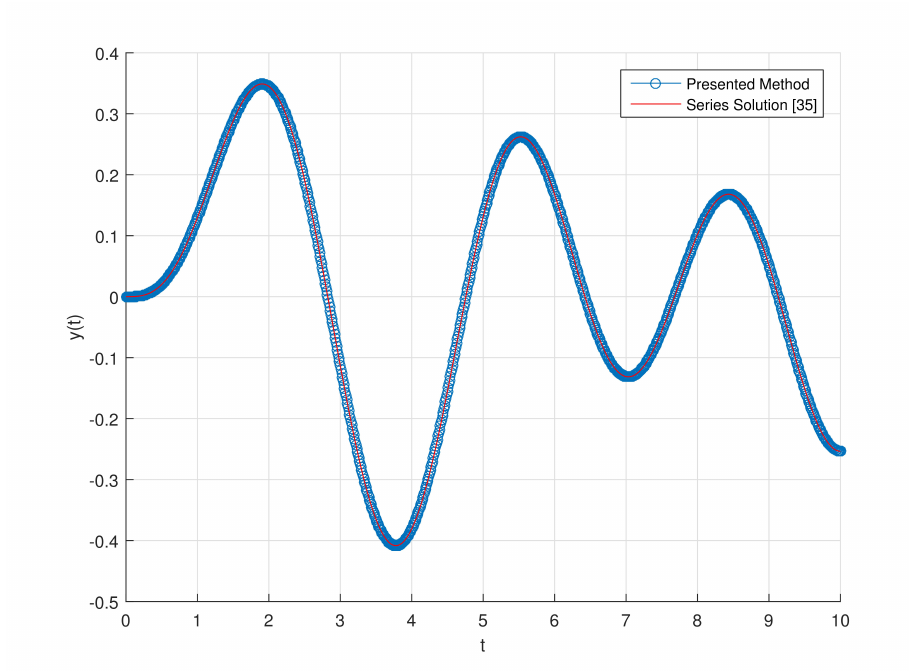
Figure 10. The behaviour of series solution and the numerical solution obtained by proposed method for the interval [ 0,10 ]